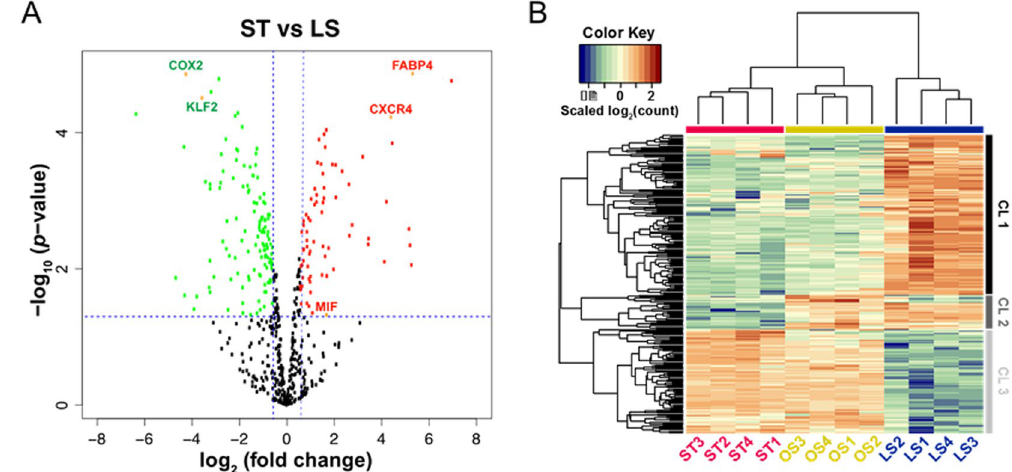
Figure 1. Modulation of genes in the inflammation category in response to different types of shear stress. ( A ) Volcano plot of all the inflammation-related genes detected in HCAECs in ST and LS conditions. y-axis is the negative log 10 of p value; x-axis is the log 2 of fold change. Green dots represent genes downregulated in HCAECs under ST condition with significant p value; red dots represent genes upregulated in HCAECs under ST condition with significant p value; black dots represent genes without significant changes. ( B ) A heat map of all the inflammation-related genes that are differentially expressed in HCAECs under different shear stress conditions. CL1, CL2 and CL3 represent gene cluster one, two and three respectively, which were determined based on similarity of expression profiles among three conditions. CL1 is comprised of genes that are stimulated by LS condition, while genes in CL3 are more active under ST and OS. CL2 contains a small group of genes that shows up-regulation in OS and LS, but not